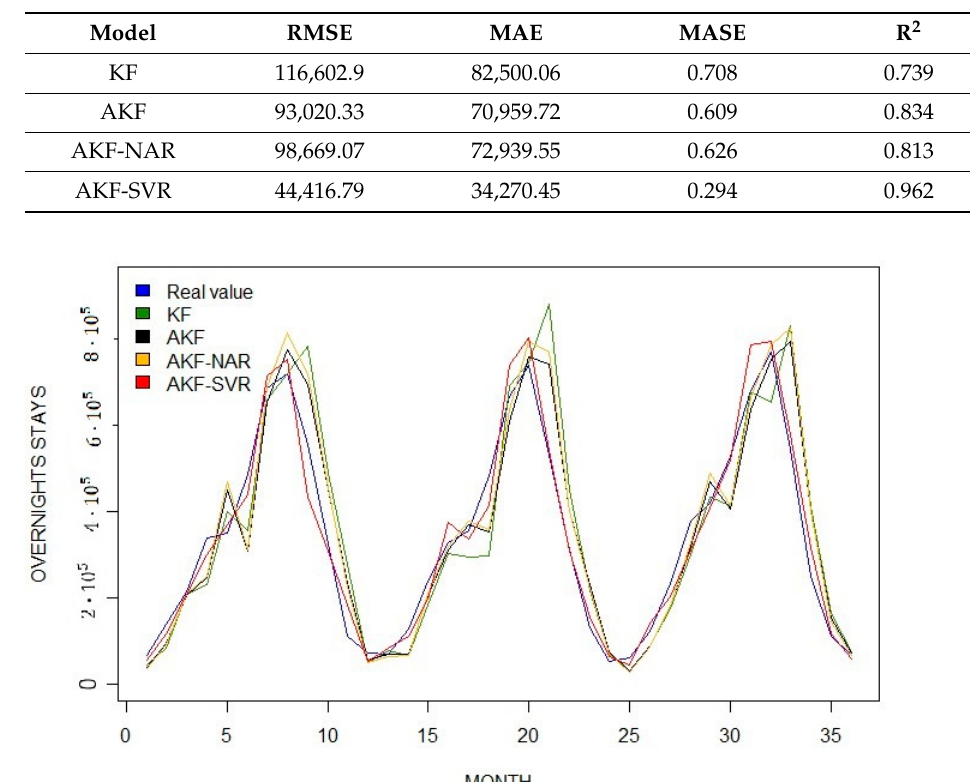
Table 4. Results for total visitors in Huelva: 2017–2019 (monthly). Table 3. Results for total overnight visitors in Huelva: 2017–2019 (monthly).